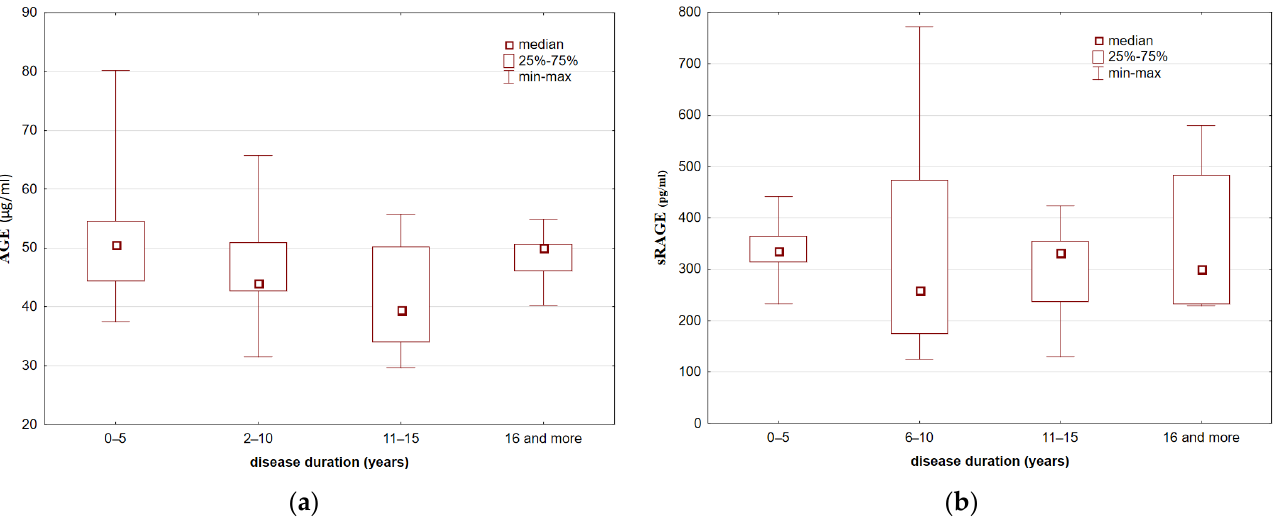
Figure 1. Serum AGE ( a ) and sRAGE; ( b ) concentrations in MS patients depending on disease duration (Kruskal–Wallis rank ANOVA test: p > 0.05).